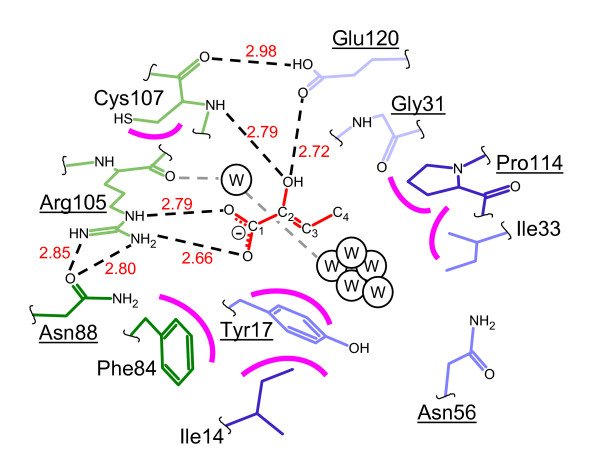
The binding of 2-ketobutyrate to TdcF. Schematic representation of the binding of 2-ketobutyrate to TdcF. 2-ketobutyrate is shown in red, whilst residues from one subunit are in green and those from the other subunit are in blue; darker colours indicate residues in the foreground and paler colours are used for those residues in the background. Underlining indicates strictly conserved residues in the YjgF/YER057c/UK114 family [8]. Important hydrogen bonds are shown as dashed lines and the curved magenta lines indicate non-bonding interactions with the ligand. The numbers in red give average hydrogen bond lengths in Å. Water molecules are indicated by the letter "W". The cluster of water molecules to the right of the ligand is in direct contact with bulk solvent. The view is similar to that seen in Figures 3–5.